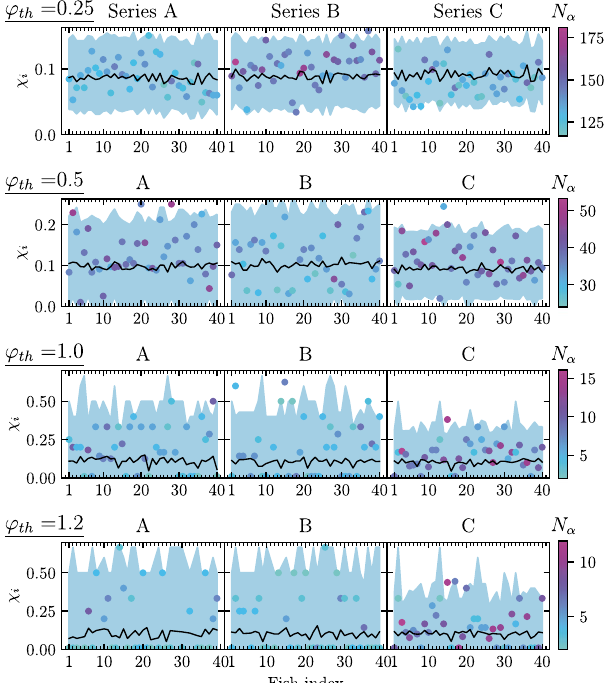
Figure 3. Leadership probability χ i computed for each fish i in the three data series considered A, B and C columns, left to right) and for different values of the turning threshold ϕ th = 0.25, 0.5, 1.0 and 1.2 (rows, top to bottom). Symbols are color-coded with the number N α of actual avalanches in which each fish participates. Full lines represent the average leadership probability in a null model of uncorrelated avalanches. The shadowed regions represents the 99% confidence interval of this